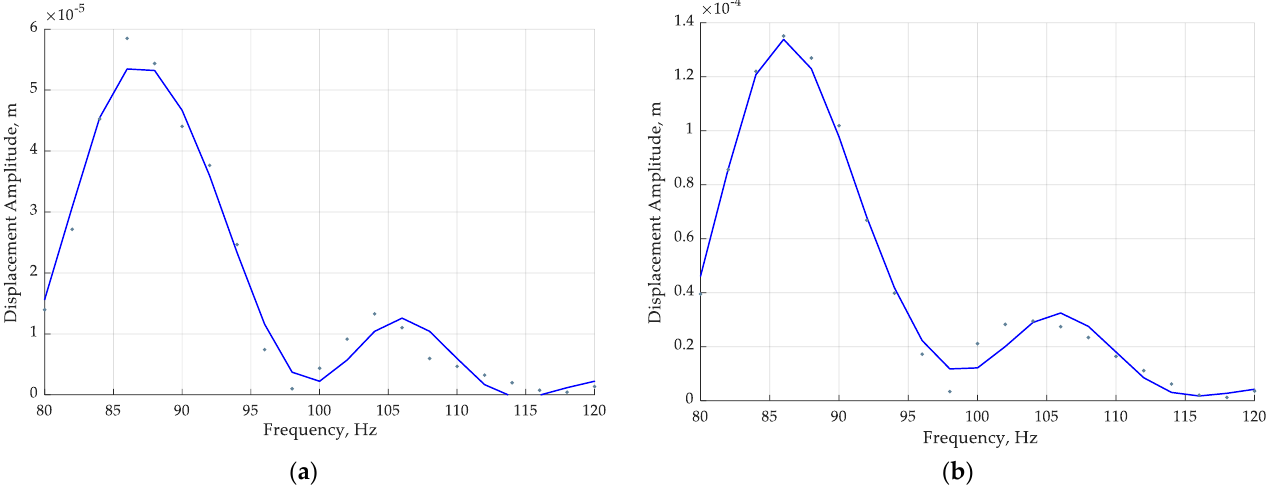
Figure 11. The amplitude frequency characteristics of the levitated magnet movement for constant input current ( a ) 0.35 A and ( b ) 0.75 A in the frequency range of 80 – 120 Hz.